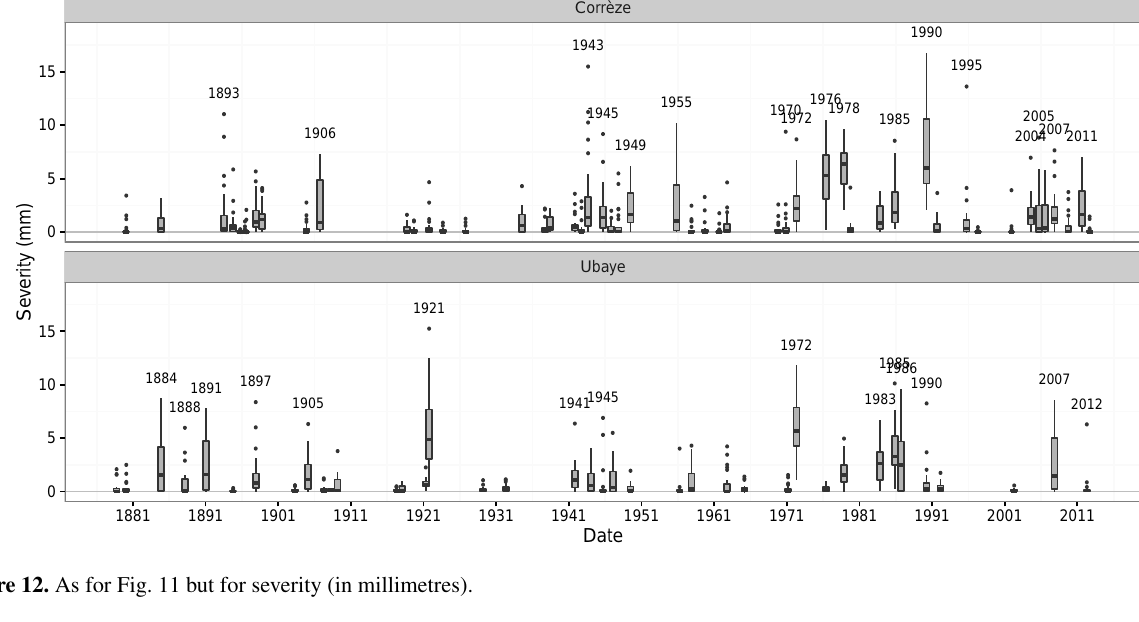
Based on Figs. 11 and 12, a higher number of events oc- curred for the Corrèze catchment than for the Ubaye catch- ment. A higher number of extreme events and higher severity values are simulated after 1940 for the Corrèze. These